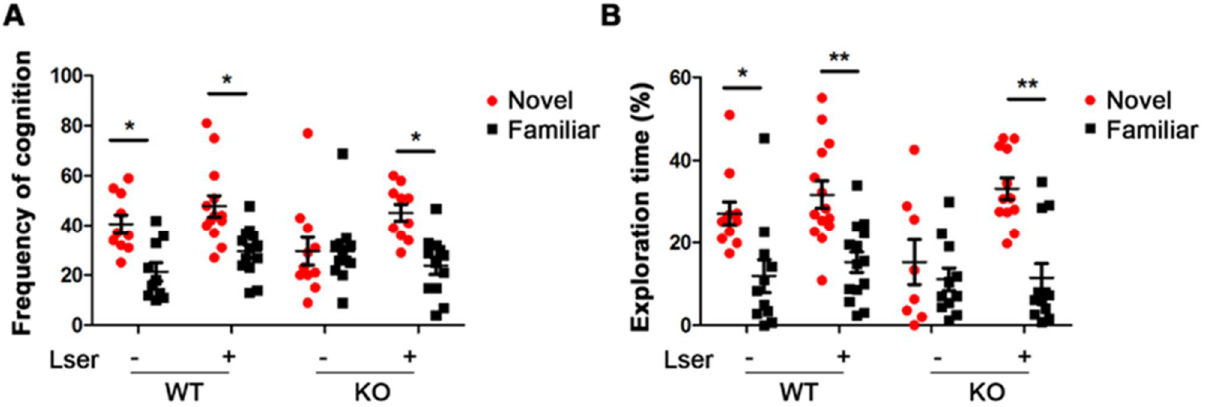
Figure 2. Oral administration of L-serine improved novel object recognition (NOR) in GHRH-KO mice. NOR was performed with GHRH-KO mice and age-matched wild type controls upon L-serine intervention for 12 weeks. ( A ) Frequency of exploration in novel and familiar objects during the entire NOR trial time. ( B ) Percentage of time spent investigating novel and familiar objects during the entire NOR trial time. n = 11–14 mice per group. Data represent means ± SEM. * p < 0.05, ** p < 0.01.